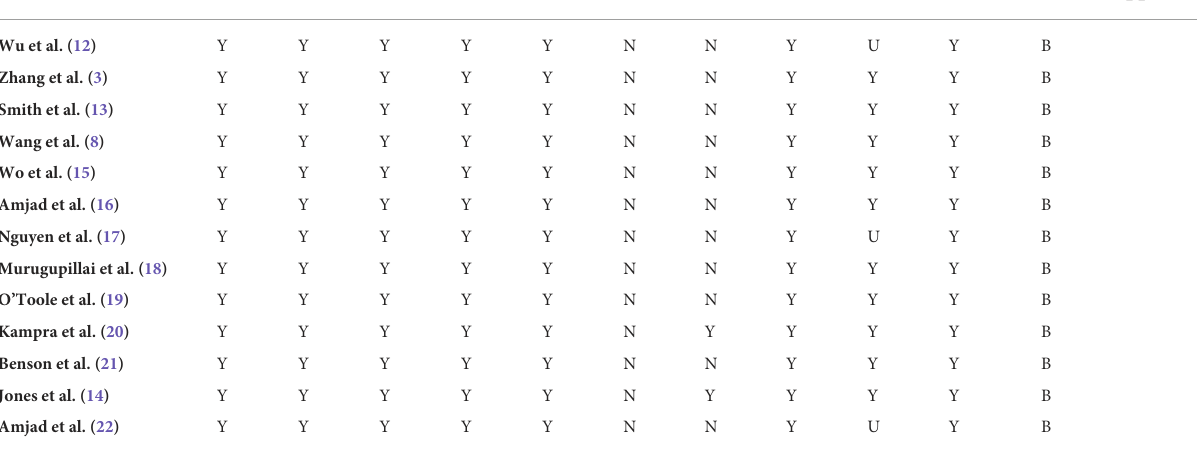
TABLE 2 Methodological quality appraisal of the included